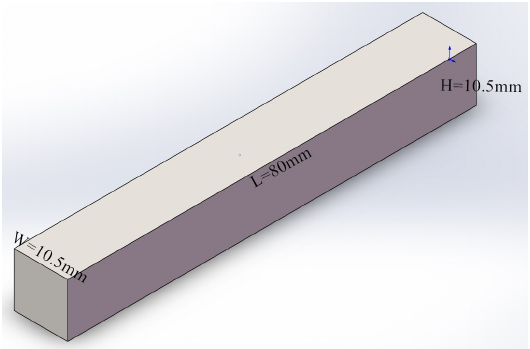
Figure 1. Shape and size of sample for Gleeble thermal simulation test.